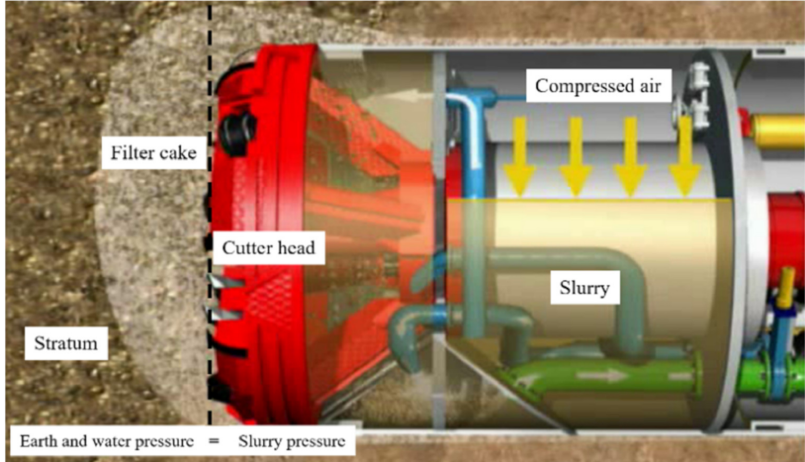
Figure 5. Principles of the slurry pressure balance